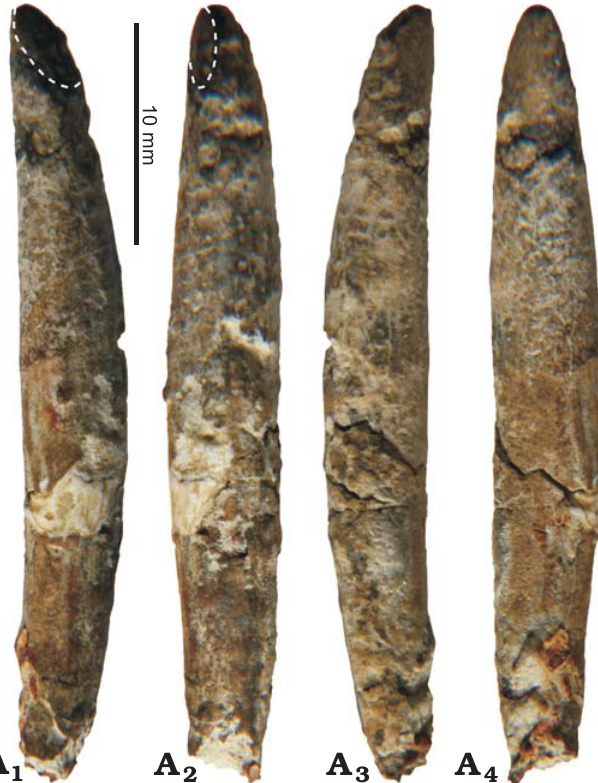
Fig. 7. Detached tooth of kogiid sperm whale Pliokogia apenninica gen. et sp. nov. (MSNUP I-17603, holotype), from the lower Pliocene of Sant’Andrea Bagni (Northern Apennines, northern Italy), in four different views (A 1 –A 4 ). The dashed line denotes the extent of the wear